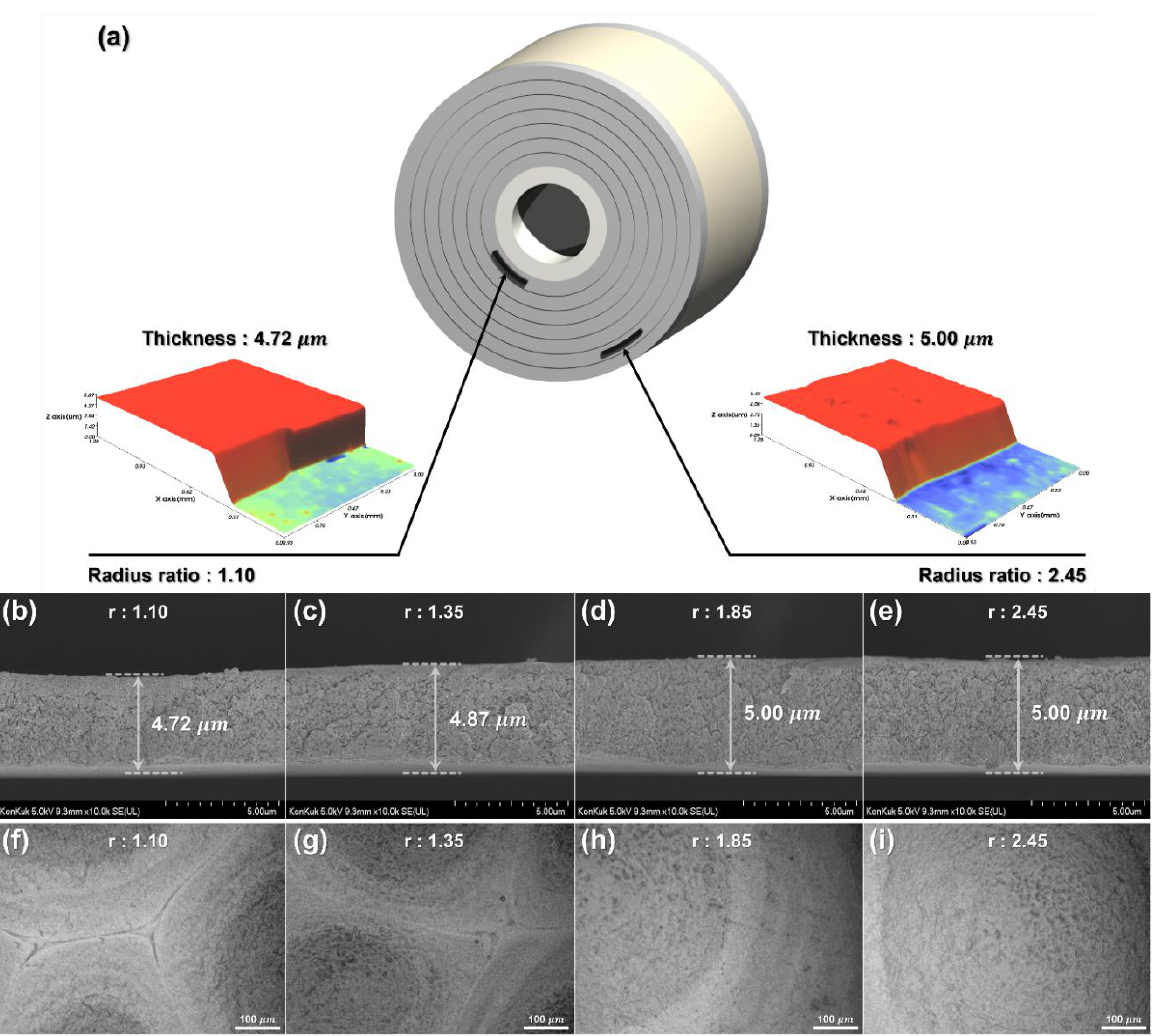
Figure 7. GDC-coated layer in the wound roll for case 2: ( a ) GDC-coated layers measured with the interferometer; ( b – e ) cross-sectional images of the GDC-coated layer located at radius ratios of 1.10, 1.35, 1.85, and 2.45, respectively; ( f – i ) surface images of the GDC-coated layer located at radius ratios of 1.10, 1.35, 1.85, and 2.45, respectively.